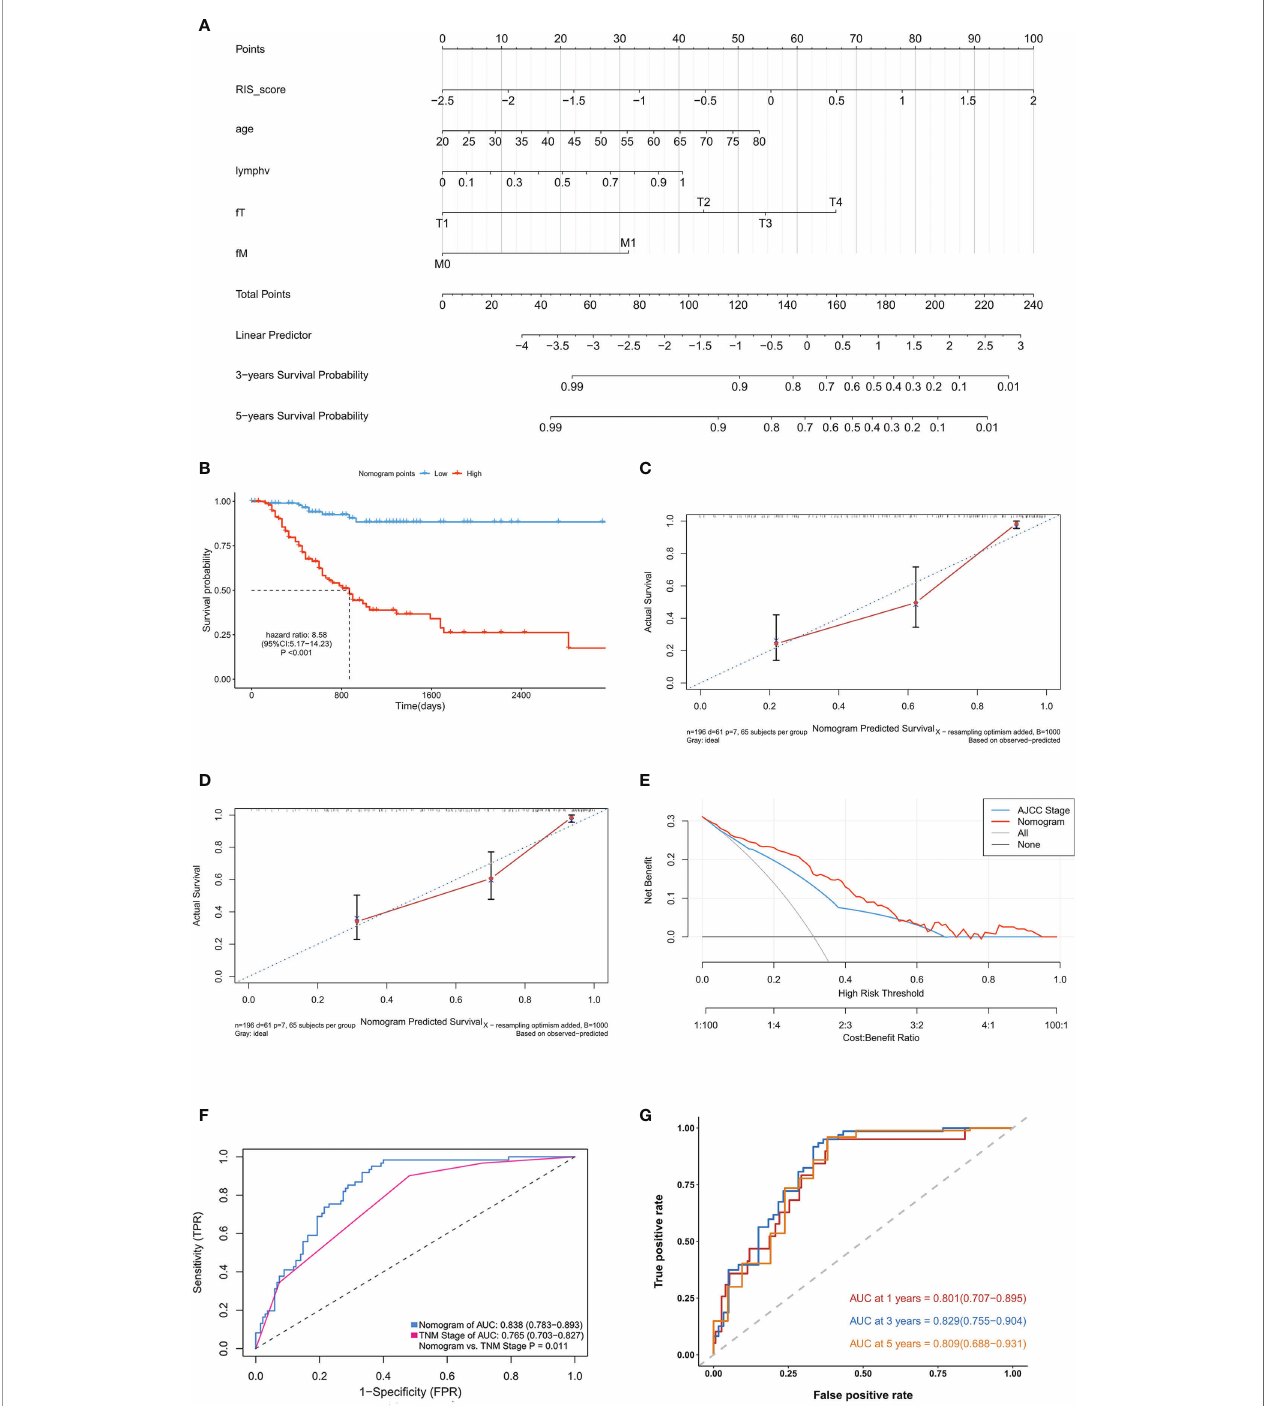
FIGURE 4 | Development and validation of the raidiomics nomogram. (A) Nomogram constructed in conjunction with the radiomics score and clinical characterization that predict the 3- and 5-year overall survival of patients with gastric cancer. (B) Kaplan – Meier curves for patients with high and low nomogram score in the training cohort. (C, D) Plots depict the calibration of radiomics nomograms in terms of agreement between predicted and observed 3-year (C) and 5- year (D) outcomes. (E) Decision curves of the nomogram model and TNM stage for the survival predictions of patients with GC. (F) The ROC comparation between the nomogram model and the TNM stage. (G) Time ‐ dependent ROC analysis of the nomogram model for OS prediction in the training cohort. The area under the ROC curve was 0.803, 0.838, and 0.811 for the nomogram score at 1, 3, and 5 years,